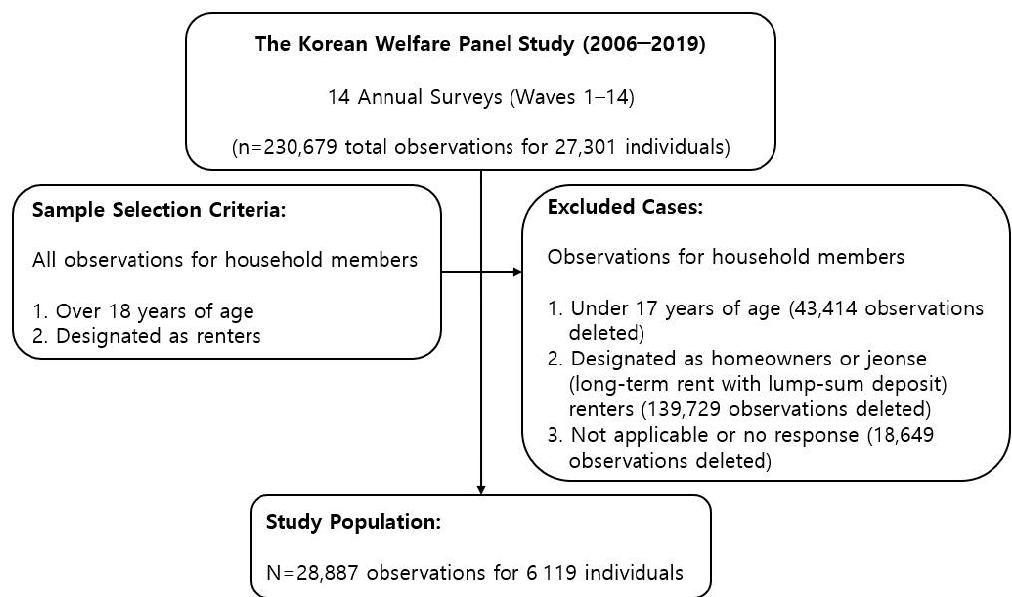
Figure 1. Description of the analytic sample selection.